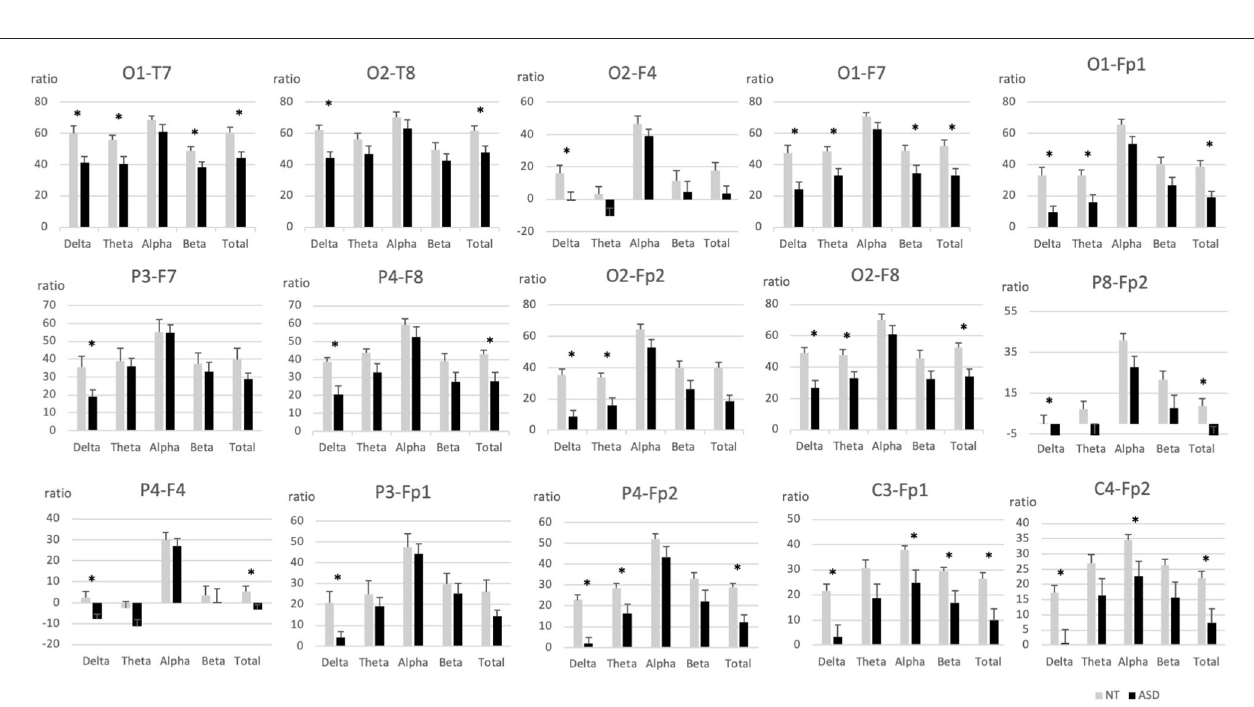
FIGURE 3 | Intrahemispheric distal ratios across frequency bands in pairs of electrodes with significant group differences. ASD, Autism spectrum disorder; EEG, Electroencephalography; NT, Neurotypical. Error bars represent standard errors of the mean. * p < 0.05.